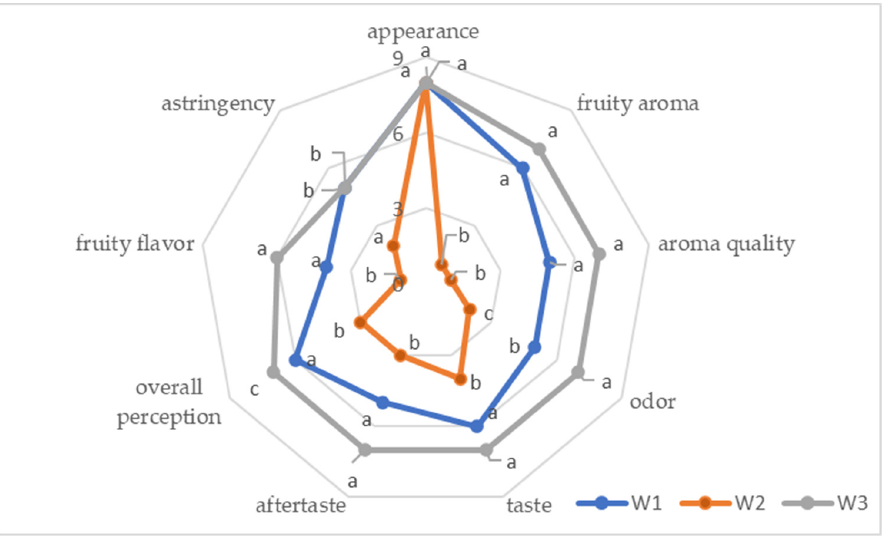
Figure 2. Spider-web graph of taste panel results. Different letters in the same series indicate sig- nificant differences between means ( p < 0.05). Scale used desirable (7–9), acceptable (4–6) and un- desirable